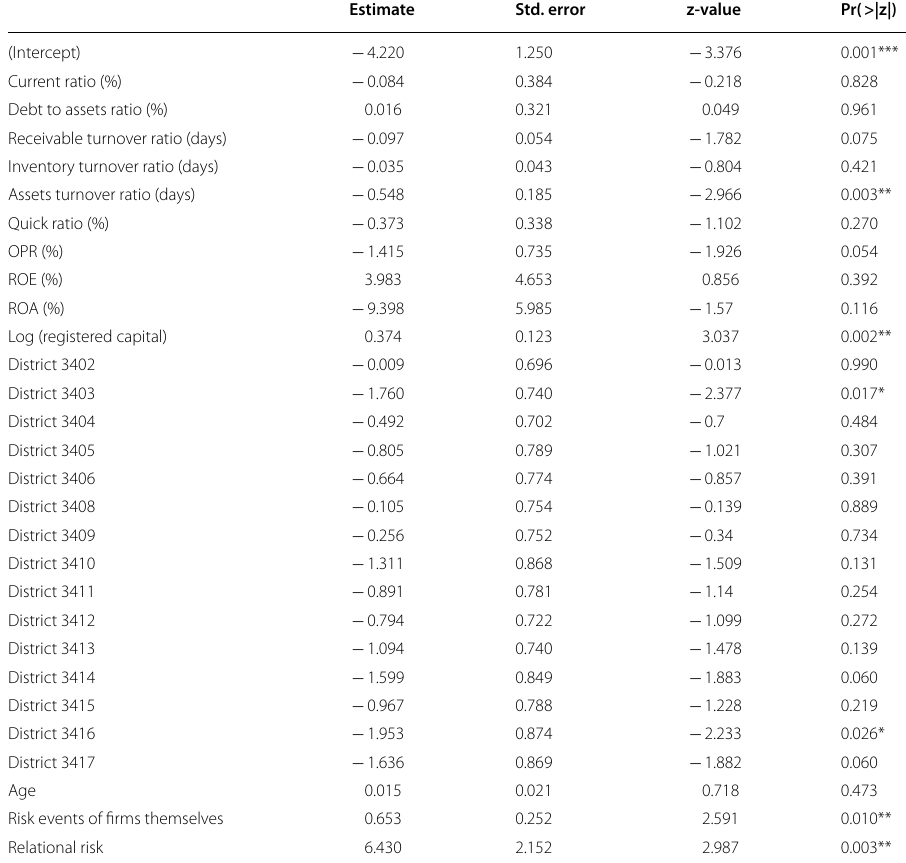
Table 32 Coefficients of features in the logistic regression model